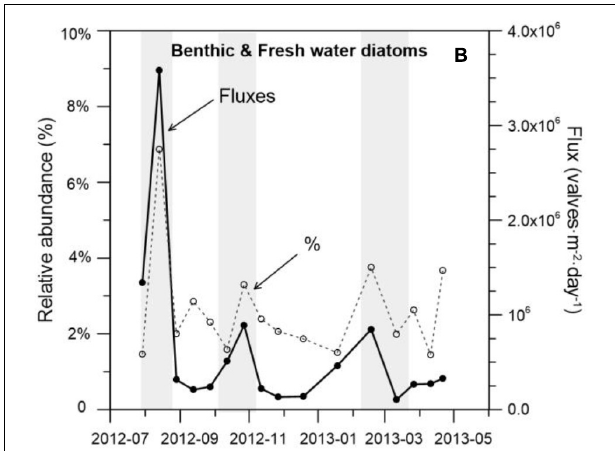
FIGURE 4 | Time-series variation in the fluxes and relative abundances of benthic and freshwater diatoms (gray bars indicate the three TPF peaks).